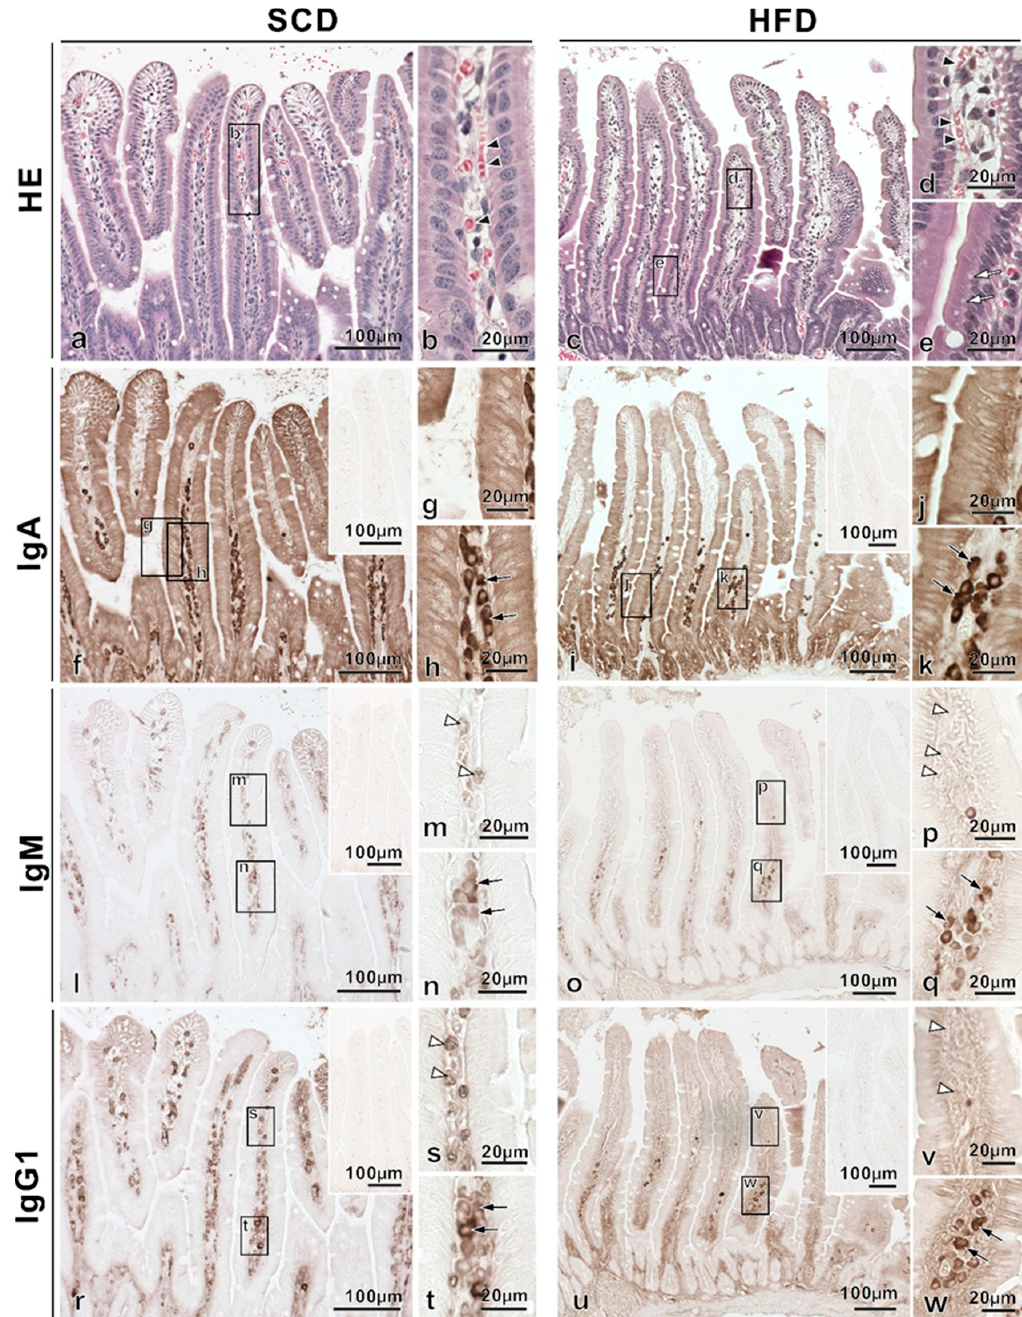
Figure 2. Comparison of the intestinal villi of standard chow diet (SCD) and high-fat-diet (HFD) fed 12-week-old mice. Paraffin-embedded tissue serial sections were obtained from each diet model. HE-staining of villi in the small intestines from SCD-fed mice showed regularly aligned simple columnar epithelium ( a , b ). HE-staining of tissues from SCD and HFD-fed mice showed red blood cells (arrowheads in b , d ). HE-staining of tissue sections from HFD-fed mice revealed vacuoles in simple columnar epithelial cells ( c , white arrows in e ). IgA-immunoreactivity was detected in the cytoplasm of epithelial cells in SCD ( f – h ) and HFD-fed mice ( i – k ), and many IgA-immunopositive cells were also observed in the lamina propria of intestinal villi (black arrows in h , k ). However, IgA-immunopositive cells in the lamina propria of intestinal villi in HFD-fed mice showed localization toward the bottom, with decreased immunopositivity compared to that in SCD-fed mice. IgM and IgG1 stainings showed common findings: Ig-immunopositive vessels (white arrowheads in m , p,s,v ) and Ig-immunopositive cells (arrows in n , q , t , w ) were observed. However, Ig-immunopositive vessels in HFD-fed mice were not immunopositive for both IgM and IgG1 (white arrowheads in p , v ). The inset also indicates immuno-controls ( f , i , l , o , r , u